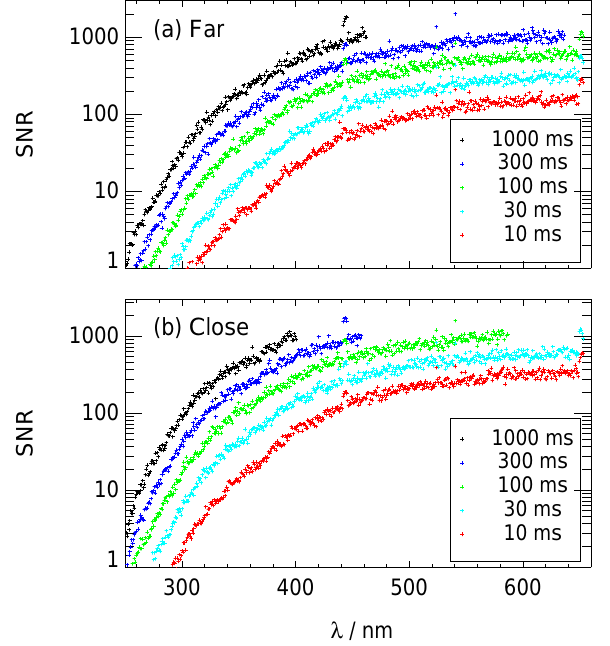
Figure 5. Signal-to-noise ratios (SNR) of 1000W irradiance stan- dard measurements with instrument 62001 as a function of wave- length for different integration times according to Eq. (7): (a) lamp distance 700mm and (b) lamp distance 350mm. The SNR is de- termined by the spectral lamp output and the instrument’s spectral sensitivity, which together produce the signal height and the corre- sponding noise (Fig. 4). The improvements for the close measure- ments are most useful for wavelengths below